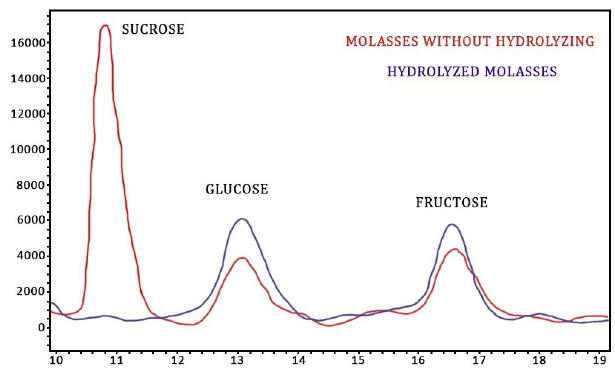
Figure 1. Sugar content in original molasses and after acid hydrolysis, determined by HPLC.